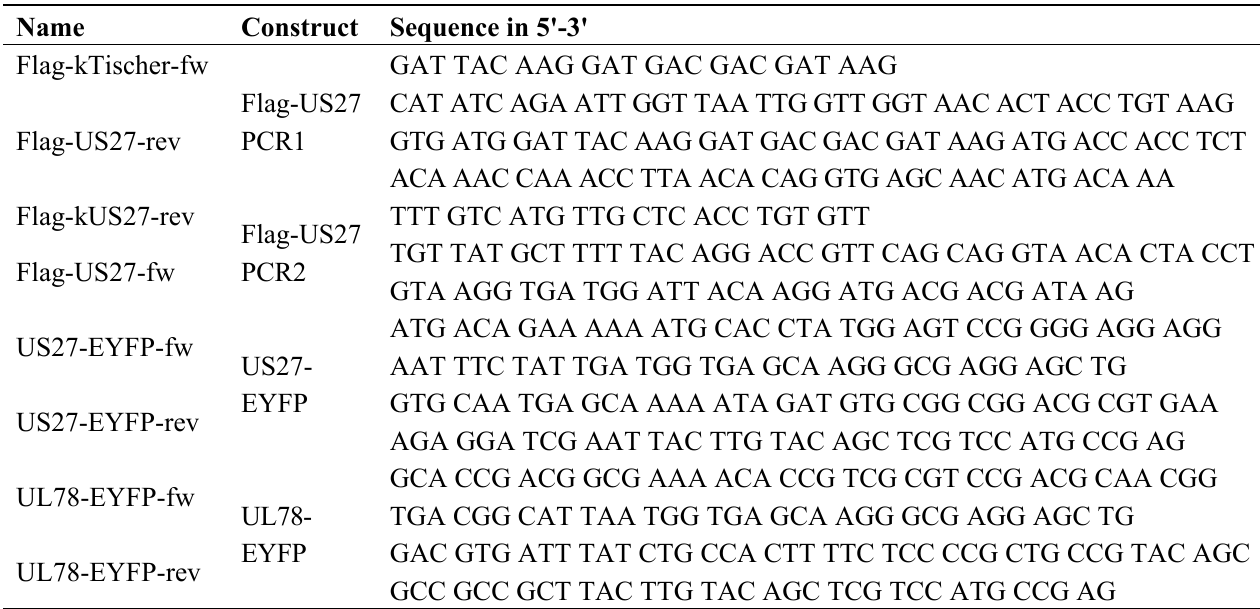
Table 1. Oligonucleotide primers for generation of recombinant human cytomegalovirus (HCMV) strains.